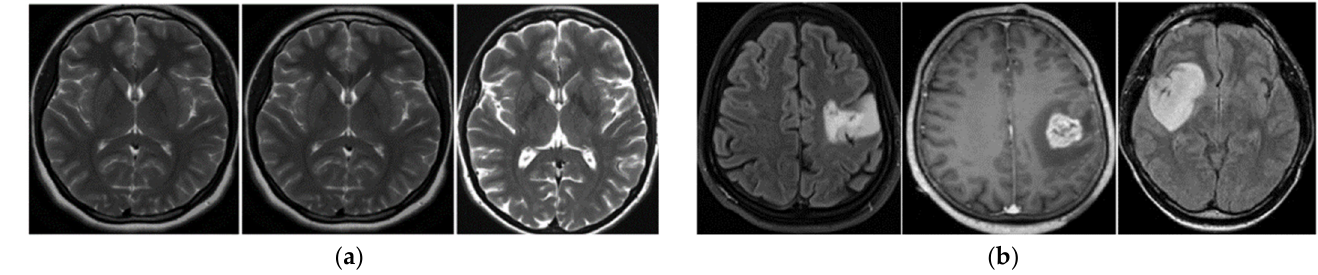
Figure 7. Example images in BT-Small: ( a ) Non-tumor brain images and ( b ) tumor brain images. Table 4. Summary of images in the BT-Small dataset.